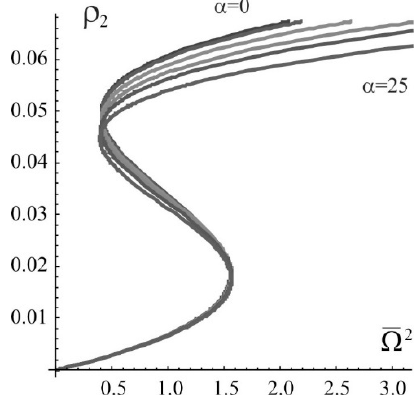
Figure 1. The bistability of the stationary population of the second excited level with a change in the Rabi frequency without taking into account the many-particle corrections. The coefficient of exciton-exciton annihilation takes the values: α = 0, 1, 5, 10, 15, and 25; frequency detuning ∆ = − 10.